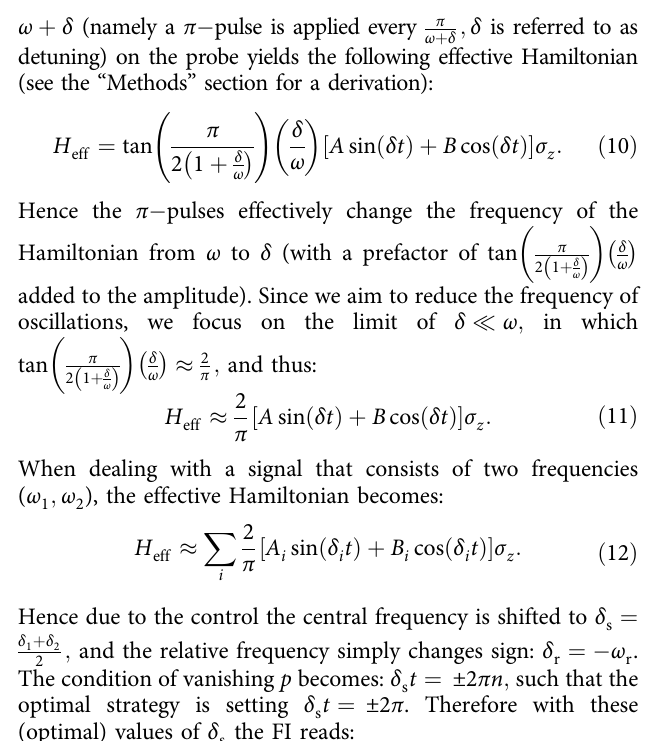
Fig. 2 The problem of resolution without coherence. The quadratures of the signal in different measurements are random. The question we address is whether resolution is limited by the length of individual